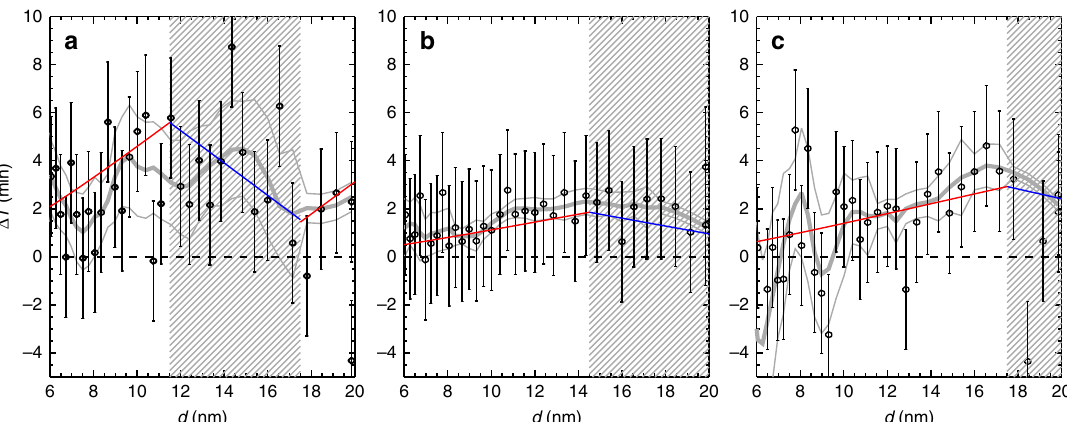
Fig. 3 Temporal evolution of growth time difference. Three examples of growth time differences Δ T versus diameter is shown as black diamond symbols along with 1 std. dev. uncertainty. Red (Blue) curves are the theoretical expectations during gamma on(off) periods based on numerical integration of Eq. (7). a Experimental run V9 (Fig. 4), based on 45 cycles of 8 h. b Experimental run V11, based on 99 cycles of 8 h. c Experimental run V7, based on 4 cycles of 8 h. The hatched regions denotes growth periods in the γ -off state. The gray curves are a LOEES smoothing of the experimental data, together with the 1 std. dev. uncertainty. The scattering of points is smallest for run V11, which has the most cycles